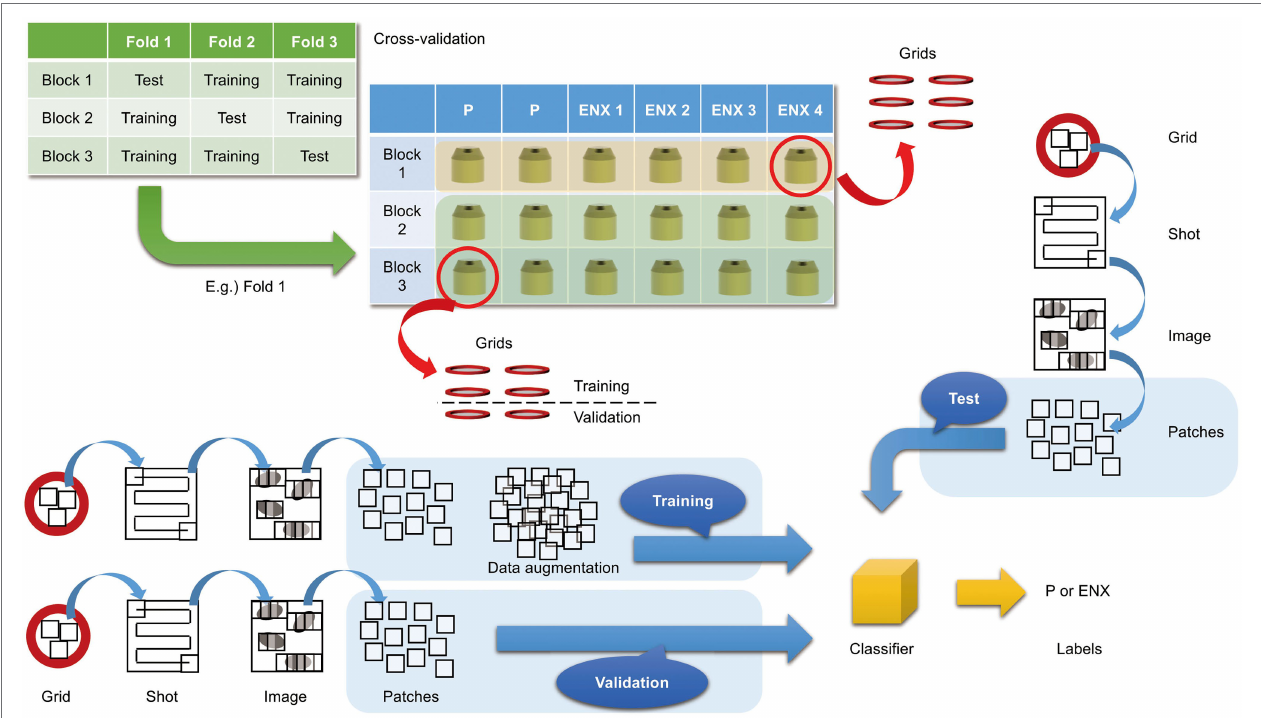
FIGURE 3 | Overview of three-fold cross-validation for prediction of ENX-resistant cells. The cartoon shows that TEM images were taken (denoted as “Shot”) from the 80-nm-thick sections on multiple grids, which were prepared from three blocks for each ENX-resistant strain and six blocks for the parental strain, and were split into three individual sets for three-fold cross-validation. In the cross-validation, four blocks of the parent strain and eight (= 4 × 2) blocks of the resistant strain were used for training, and two blocks of the parent strain and four (= 4 × 1) blocks of the resistant strain were used for testing. Thus, the test was done on completely unseen blocks. Numerous patches containing portions of cross sections of bacterial cells were extracted from TEM images and used for training, validation, and tests for classifier models (see also Materials and